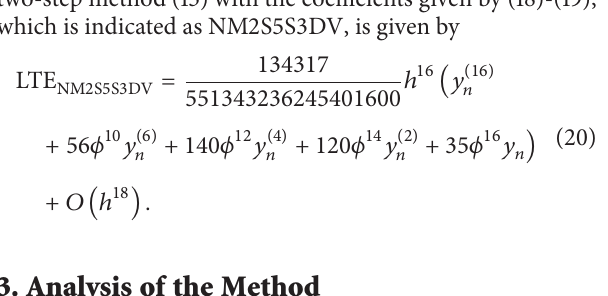
The local truncation error of the new developed five-stage two-step method (15) with the coefficients given by (18)-(19), which is indicated as NM 2 S 5 S 3 DV, is given